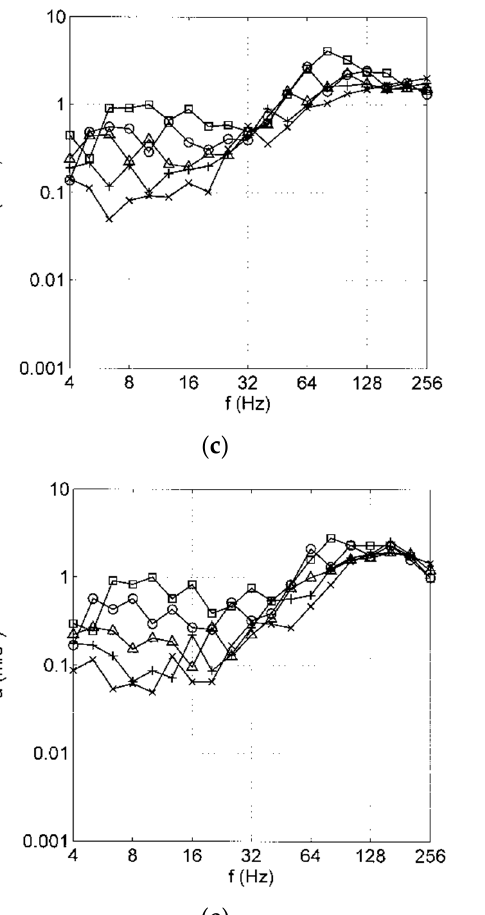
Figure 1. ( a ) Measurement points of the railway vehicle (passenger car) for the test runs, axle boxes A1, A2, bogie B1 and B2, carriage C1 and C2, right hand side, A3, A4, B3, B4, C3, C4 symmetrically Figure 4. Vibrations of the railway vehicle, one-third octave band spectra for different train speeds Figure 4. Vibrations of the railway vehicle, one‑third octave band spectra for different train speeds on the left hand side; ( b ) one-third octave band spectra of the accelerations of the railway vehicle  160,  125,  100,  80,  63 km/h, ( a ) car body C1, ( b ) bogie B3, ( c ) wheel A1, ( d ) wheel A2, ( e ) 160, # 125, △ 100, + 80, × 63 km/h, ( a ) car body C1, ( b ) bogie B3, ( c ) wheel A1, ( d ) wheel A2, running with v T = 160 km/h,  ,  wheelset A1 and A2,  ,  vertical bogie part B1 and B2,  wheel A3, ( f ) wheel A4. horizontal bogie part B1,  ,  car body part C1 and C2; ( c ) particle velocities of the track  ,  left ( e ) wheel A3, ( f ) wheel and right rail,  ,  sleeper 1 and 2,  , sleeper horizontal,  sub soil at 2.5 m distance.